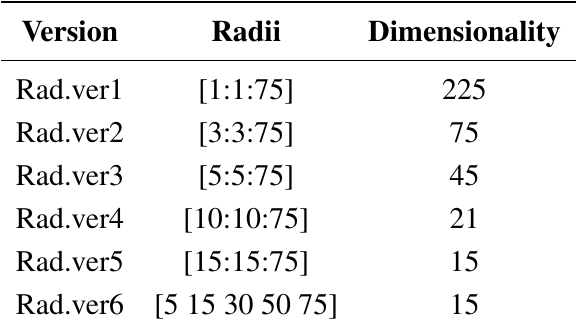
Table A3. Radii of circular regions.